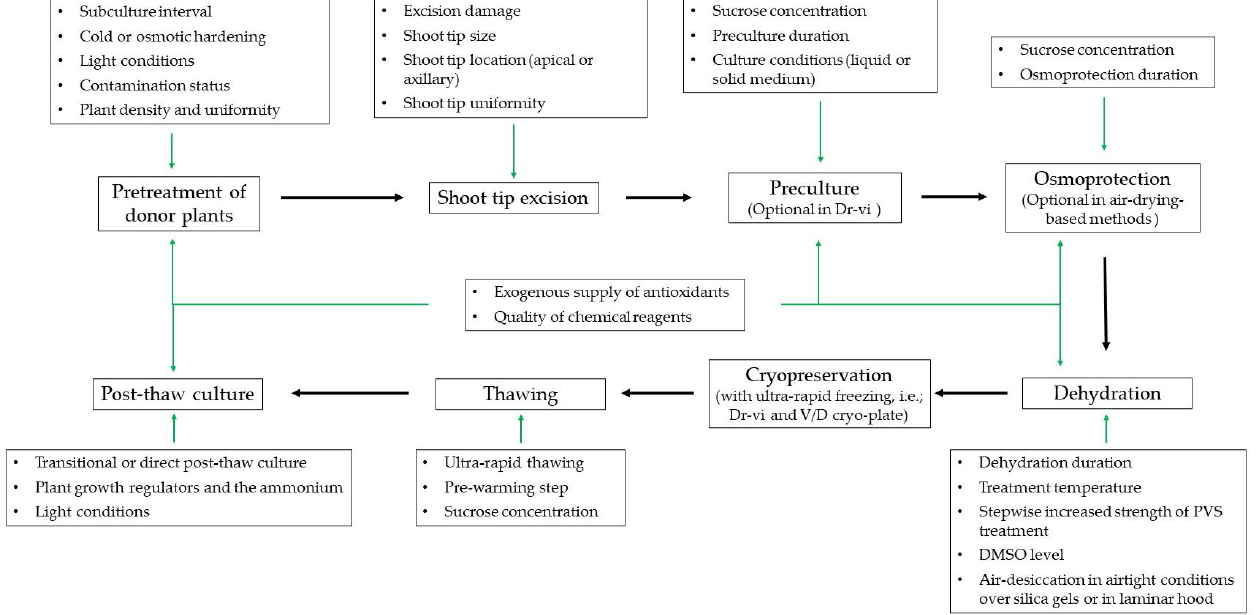
Figure 3. Factor that can be considered during the development of a shoot tip cryopreservation pro- tocol. Black arrows point to the major steps following the shoot tip cryopreservation, while green arrows indicate strategies that could be considered for each step. Abbreviations: DMSO, dimethyl sulfoxide; Dr-vi, Droplet-vitrification; PVS, plant vitrification solution; V/D cryo-plate, Vitrification/Dehydration cryo-plate.